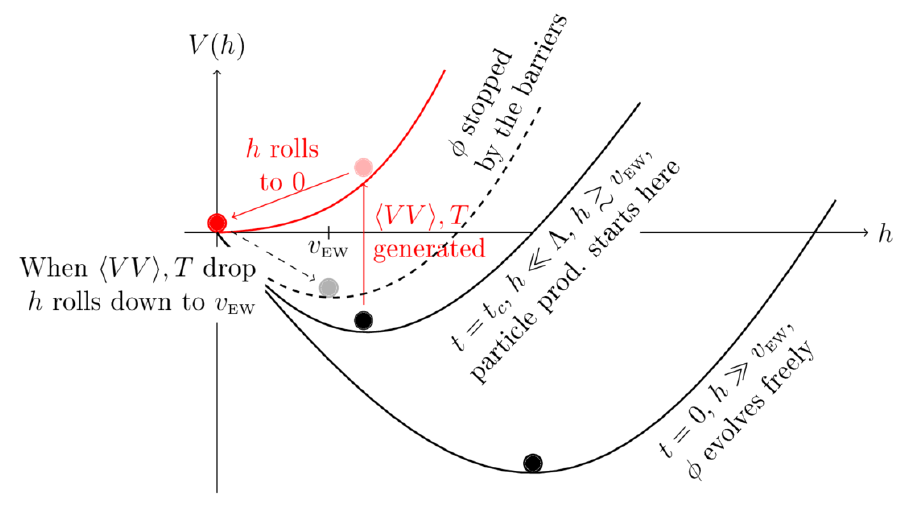
Figure 6 . Evolution of the Higgs (cid:12)eld during cosmological relaxation intertwined with gauge boson